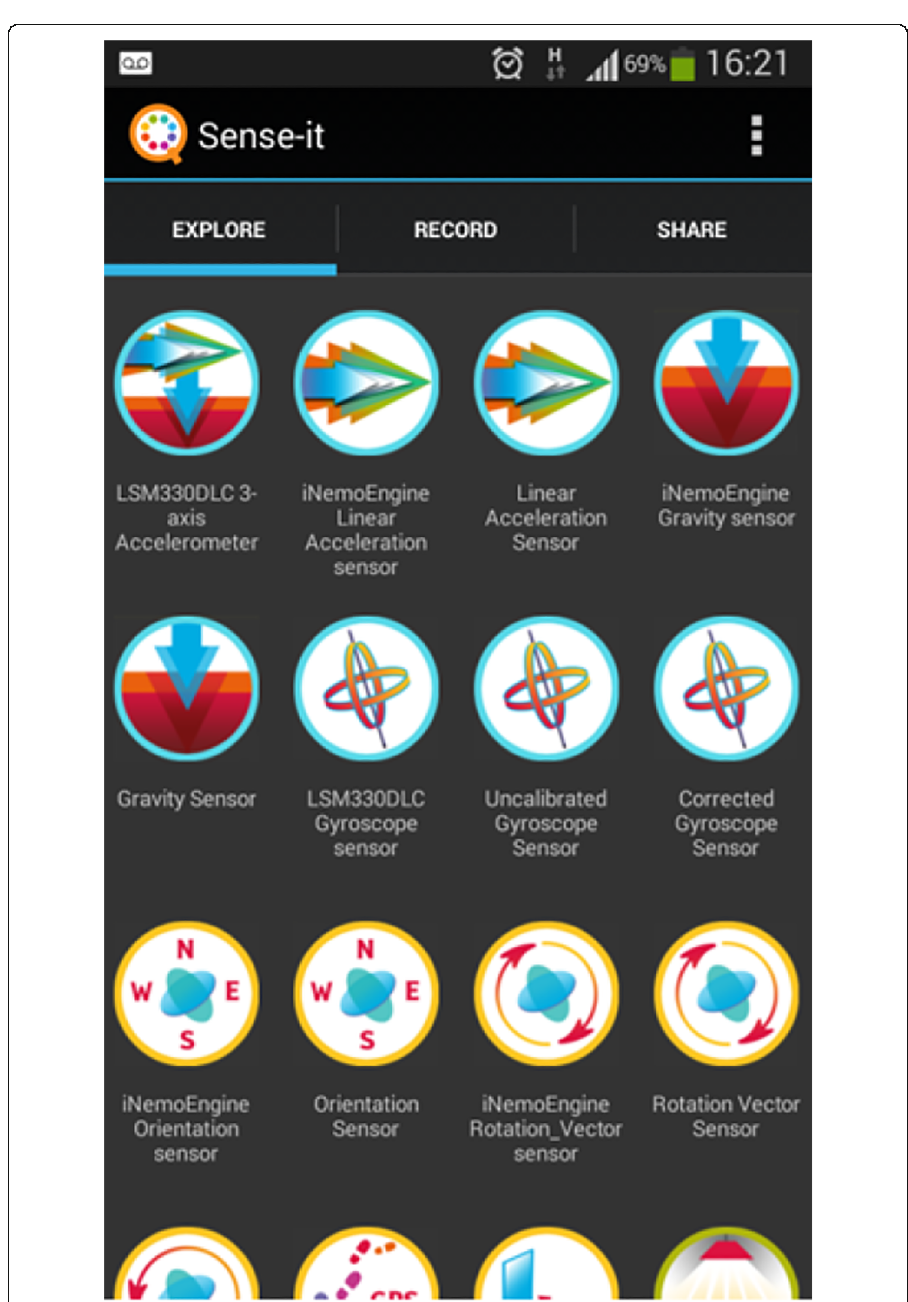
Fig. 1 The Explore tab showing the number of sensors available on a given mobile Android device such as accelerometer, gravity sensor, and orientation